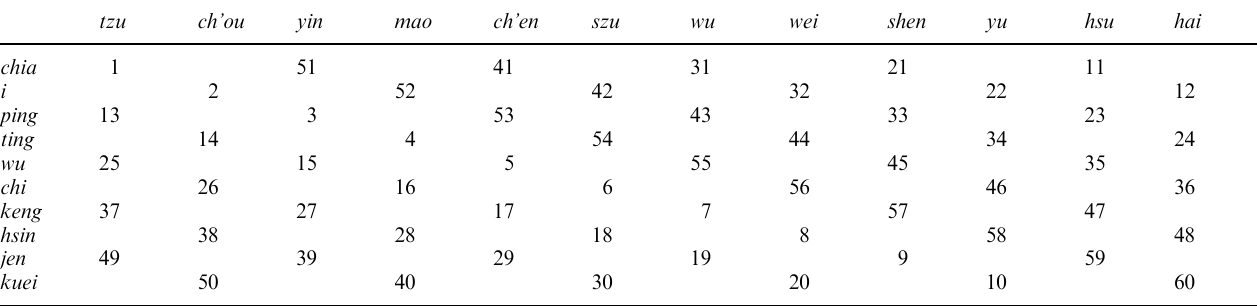
Table 2. The Chinese sexagenary